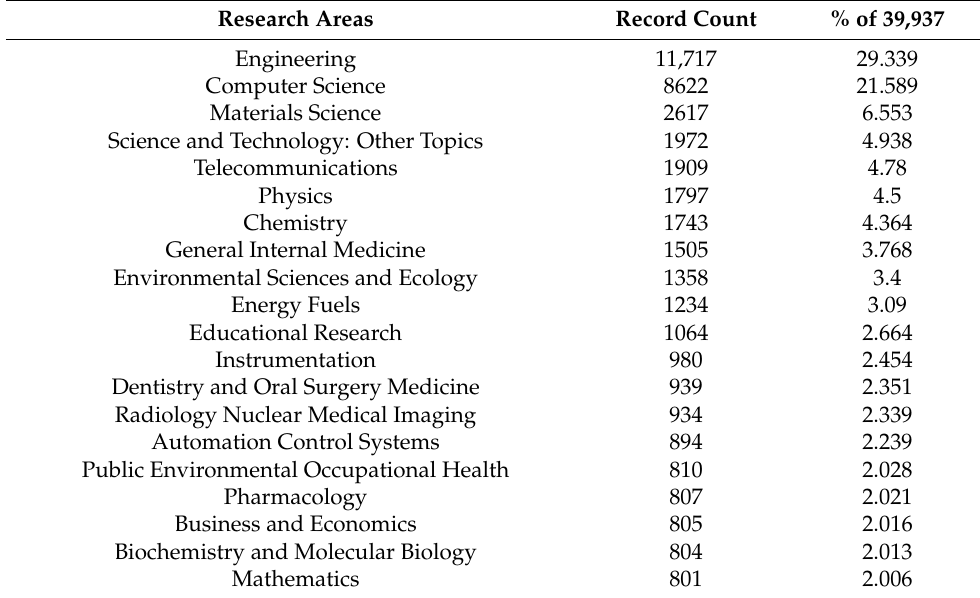
Table 8. Top 20 Research Areas based upon record count of the publications